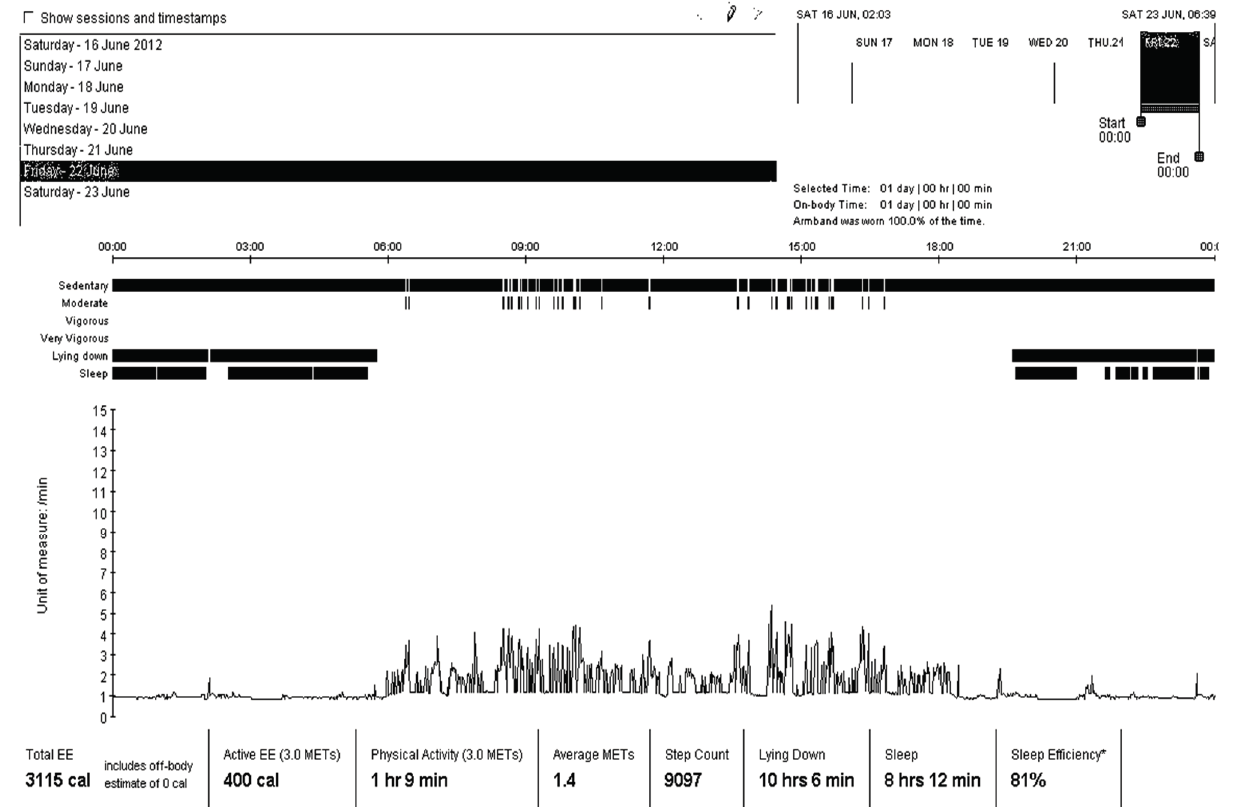
Figure 2. Pattern over 1